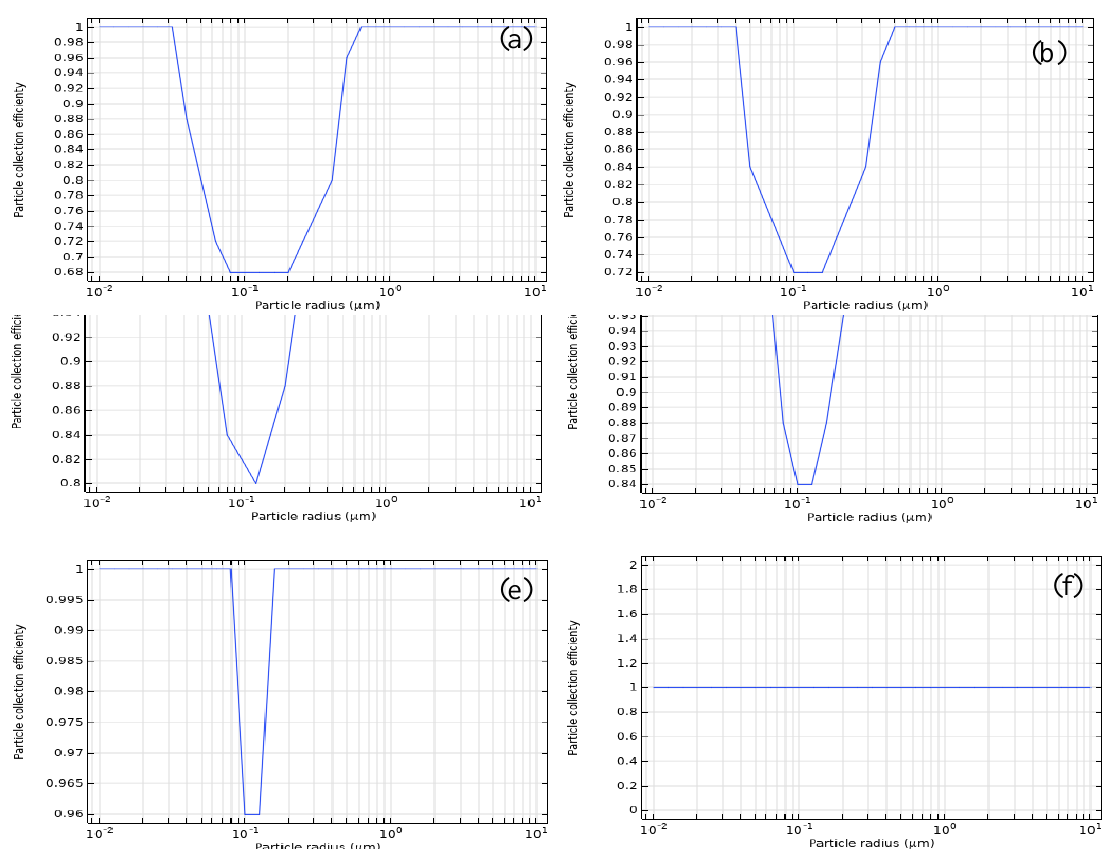
Figure 8: Particle collection efficiency as a function of the particle radius for different applied voltage a) 20kv, b) 22kv, c) 25kv, d) 26kv, e) 28kv, f)